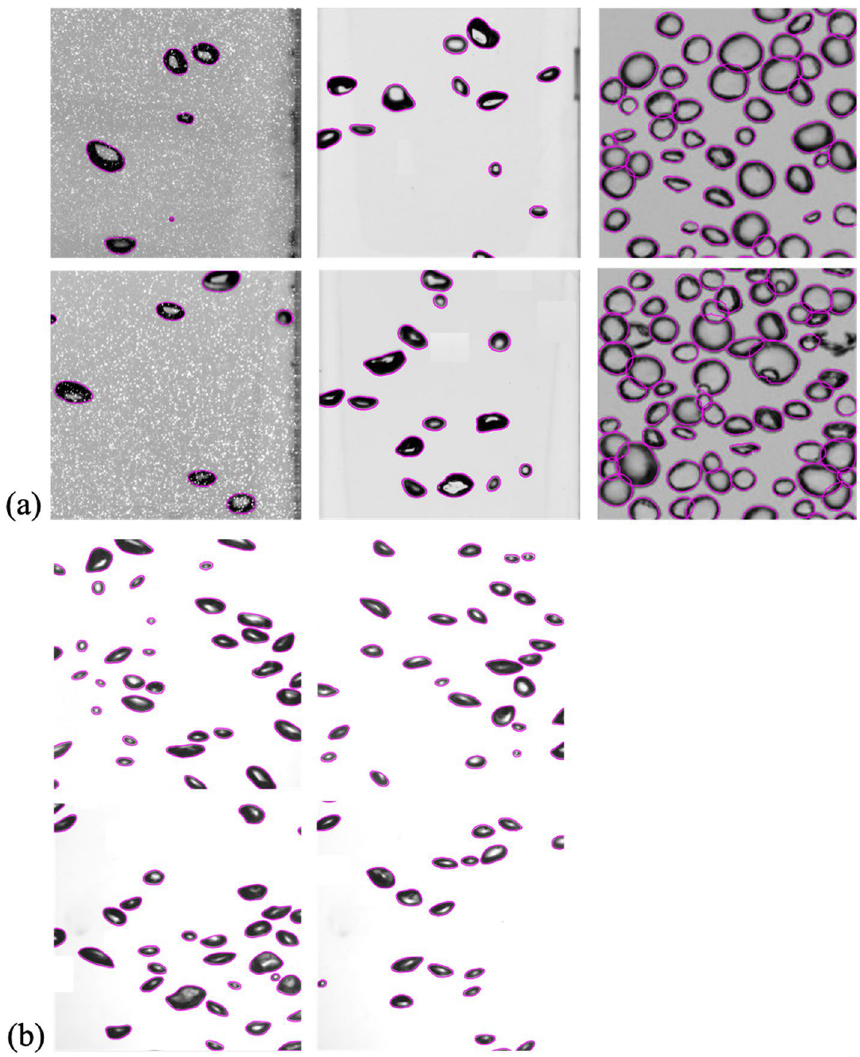
Figure 3. Bubble detection examples (IoU threshold of 0.5) for ( a ) test set #2 and ( b ) #3. Here, the purple solid lines denote the extracted bubble shapes, and the images were cropped from original images and scaled for better